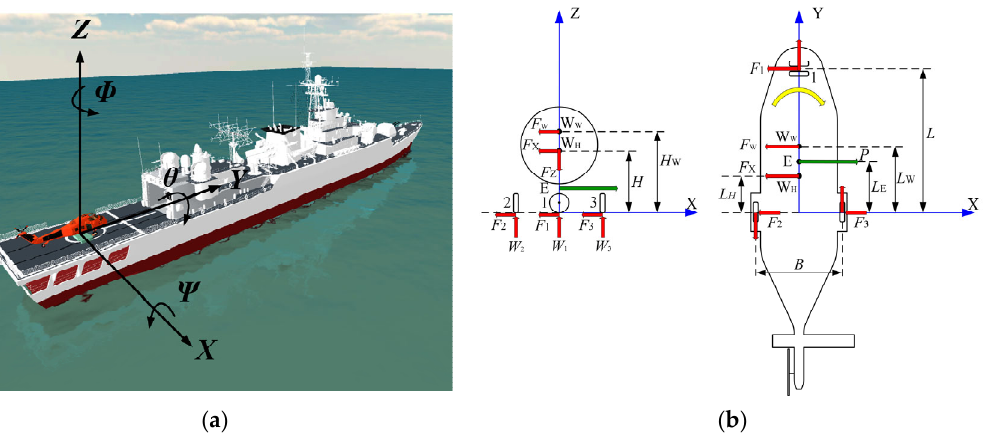
Figure 4. Model of helicopter and ship. ( a ) Six degrees of freedom motion of the ship; ( b ) the diagram of helicopter dynamics analysis.